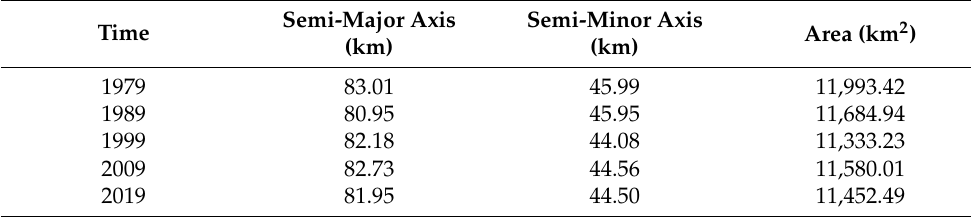
Table 3. Statistics of standard deviation ellipse parameter.